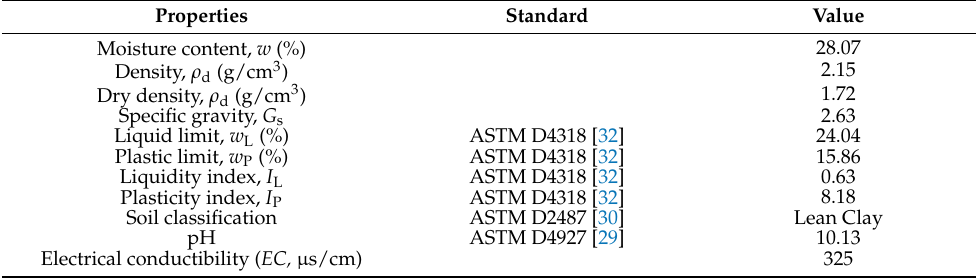
Table 2. Chemical compositions of the shield residues, GGBS, and MgO. Oxide Chemistry